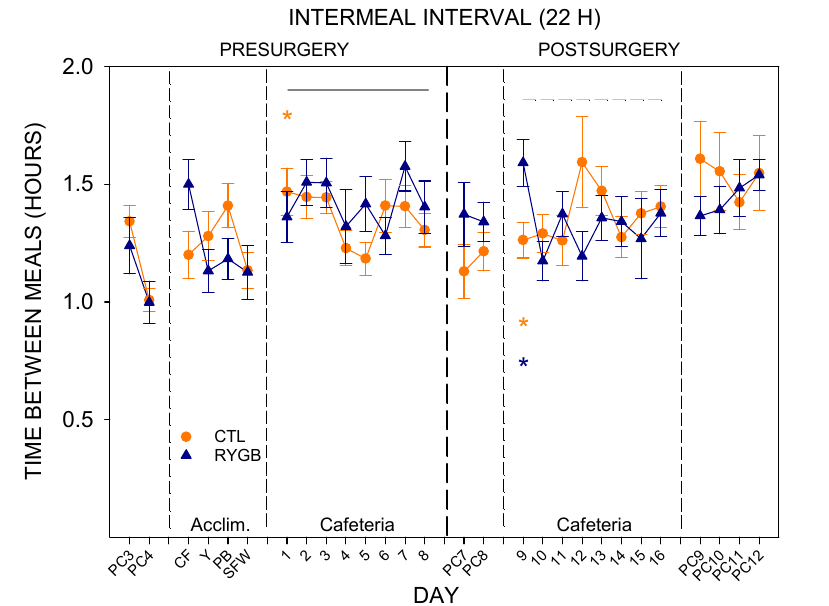
Figure 10. Intermeal Intervals across All 22-H Periods during Meal Pattern Monitoring. Mean (±SE) time between meals (in hours) for CTL (combined SHAM and IRON groups, n = 14; orange circles) and RYGB ( n = 11; blue triangles) rats for powdered chow days (PC), acclimation days for each food (Acclim.; CF: chickpea flour; Y: yogurt; PB: peanut butter; SFW: sugar/fat whip), and cafeteria diet days. Dashed vertical lines indicate transitions between diet conditions (thin dashed) and between pre- and post-surgical phases (thick dashed). Statistically significant results from two-way mixed ANOVAs (Table 12) are indicated by horizontal lines: Gray solid (group), dark gray solid (day), or gray dashed (group × day interaction). *: Statistically significant result of a paired t -test (Table 13) for the group indicated by color, comparing the marked day to the previous day.